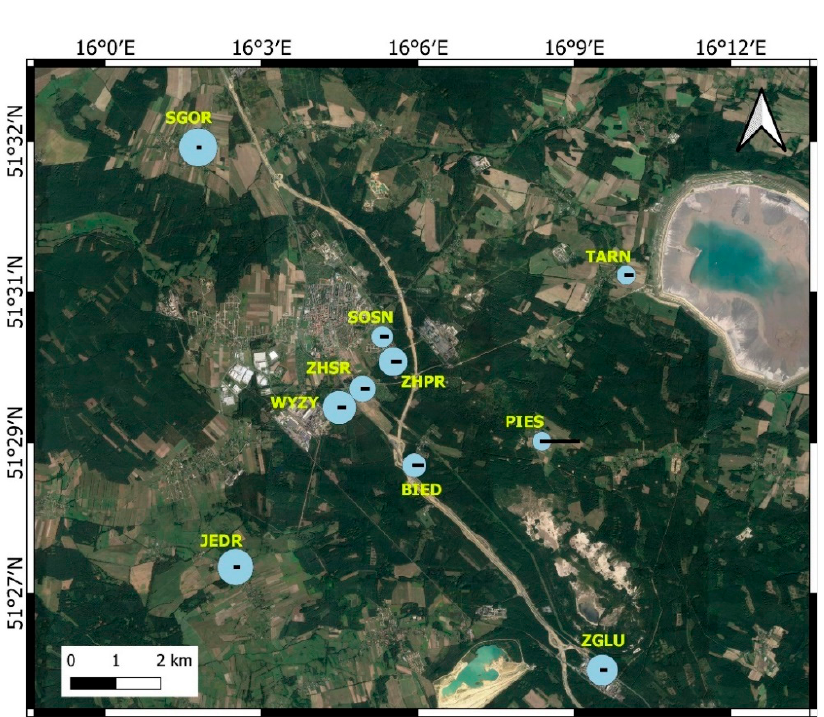
Figure 8. Displacement time series comparing MTInSAR (blue) and GNSS data projected onto the radar line of sight (red), for the points in the vicinity of the GNSS stations: ZHSR, asc ( a ) and desc ( b ); PIES, asc ( c ) and desc ( d ); ZHPR, asc ( e ) and desc ( f ); WYZY, asc ( g ) and desc ( h ). The seismic tremor recorded by the WYZY station on 22 July is noticeable in both D A and D D time series shown in Figure 8g,h, with an estimated discontinuity of about 25 mm. The study of co-seismic interferograms enables a more accurate deformation estimation, as they are differential interferograms whose master and slave images are recorded shortly before and after the event date.